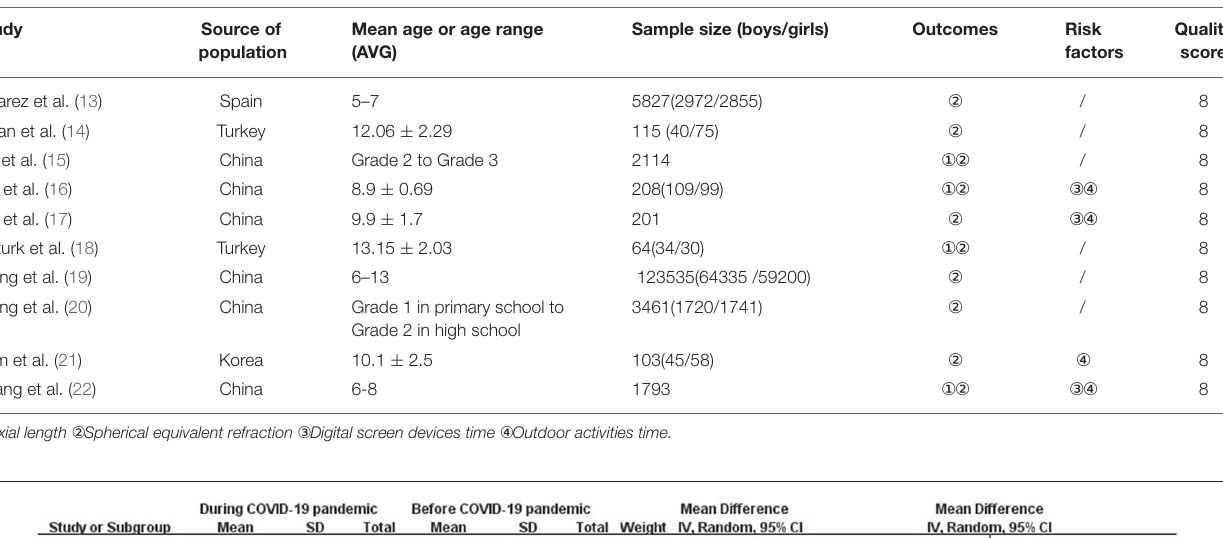
TABLE 1 | Characteristics of the 10 studies included in the meta-analysis.